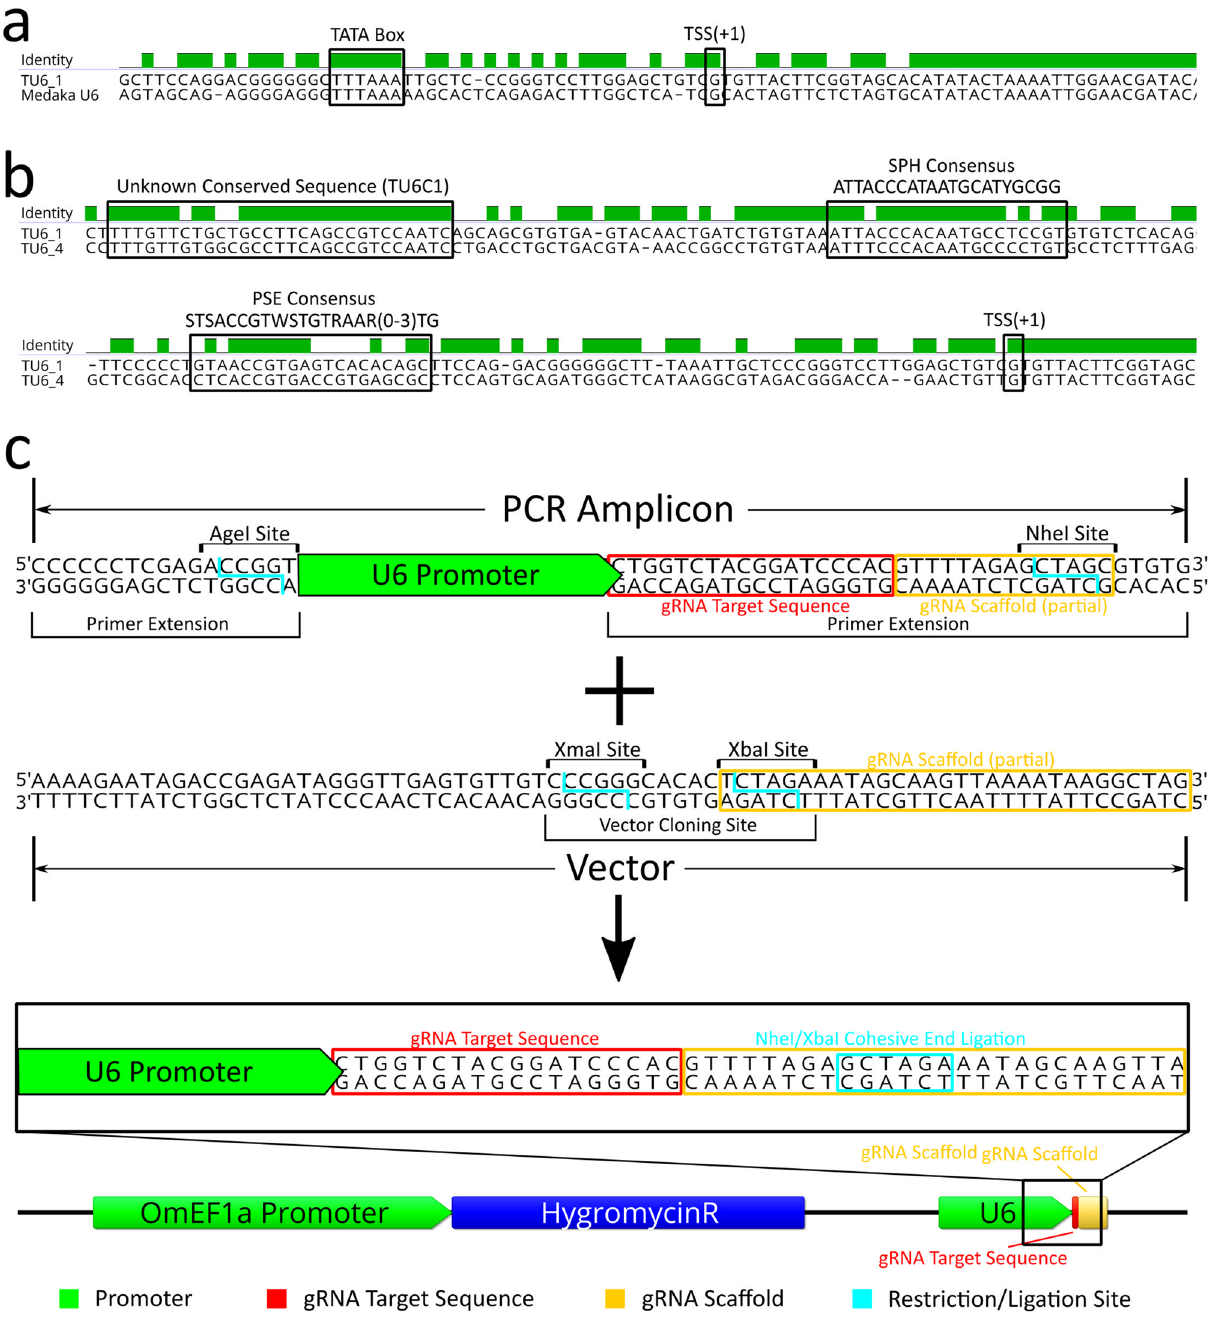
Figure 3. Identification/characterization of O. mossambicus U6 promoter by BLAST/sequence alignment and cloning into gRNA expression vector. ( a ) Sequence alignment of the tilapia U6 and the Medaka U6 template used to identify it by BLAST search shows a highly conserved transcribed region and the TATA Box (− 31 to − 23 from transcription start site, TSS). ( b ) Sequence alignment of two candidate tilapia U6 promoters (1 and 4) identified by BLAST searches. Presumptive important U6 regulatory elements are highlighted, including a sequences that are similar to the vertebrate consensus PSE, vertebrate consensus SPH, and an unknown sequence that is highly conserved in the two tilapia U6 promoters (designated as TU6C1). ( c ) Schematic of the initial cloning strategy used to generate the U6 gRNA expression vectors. The base vector contains the gRNA scaffold sequence (yellow box) in which the 9th bp was changed from a G to a T to form a XbaI restriction site. Wild-type TU6, HU6, and ZU6 cassettes were generated by PCR amplification of the U6 promoter in which an extension of the reverse primer includes the gRNA target sequence (red box) and the 5 ′ thirteen bases of the gRNA scaffold modified to form a NheI restriction site. Ligation of the amplicon into the vector by NheI/XbaI complimentary cohesive ends (blue box) forms the complete gRNA scaffold sequence of the final vector. DNA sequence alignments, sequence images, and vector map were generated using Geneious 11.0.3 (Biomatters, https:// www. genei ous. com). Image editing and assembly into complete figures was performed using Inkscape 0.92 (https:// www. inksc ape.